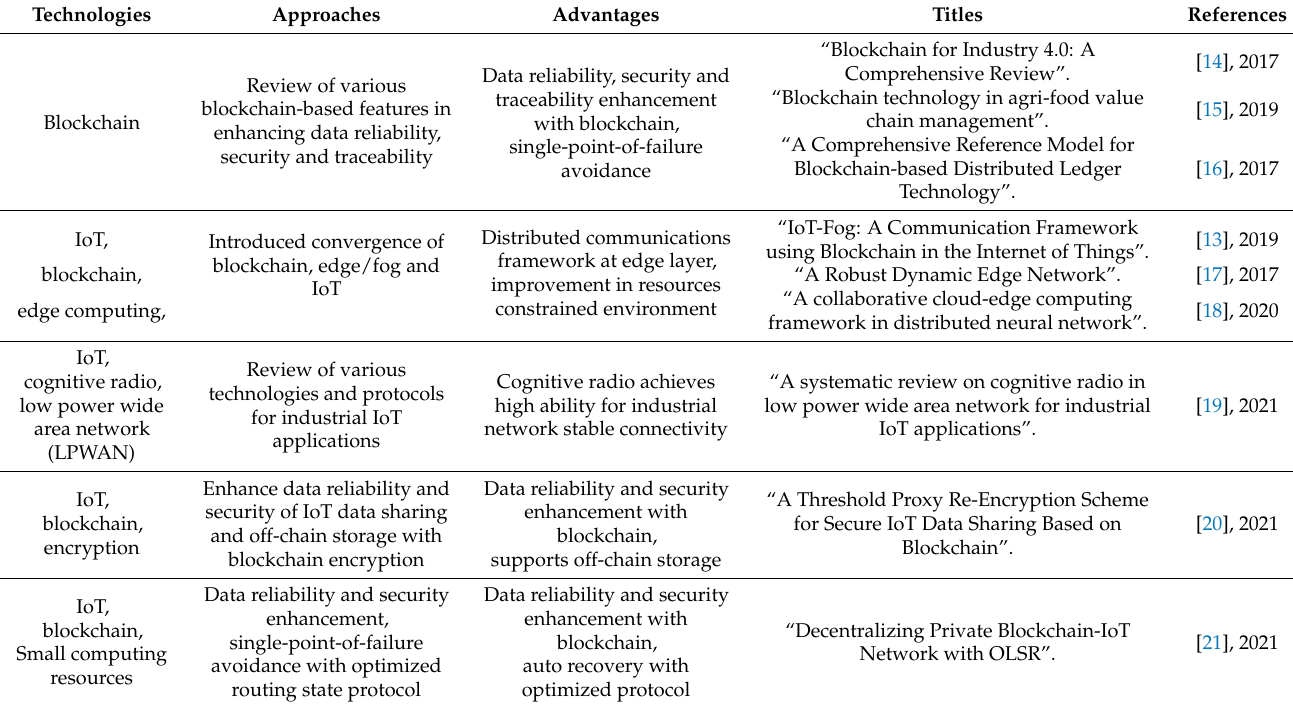
Table 3. IoT edge computing and blockchain related works.